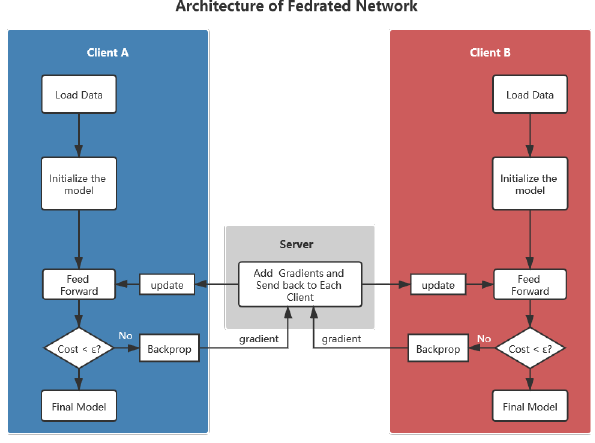
Figure 2. The architecture of the federated neural